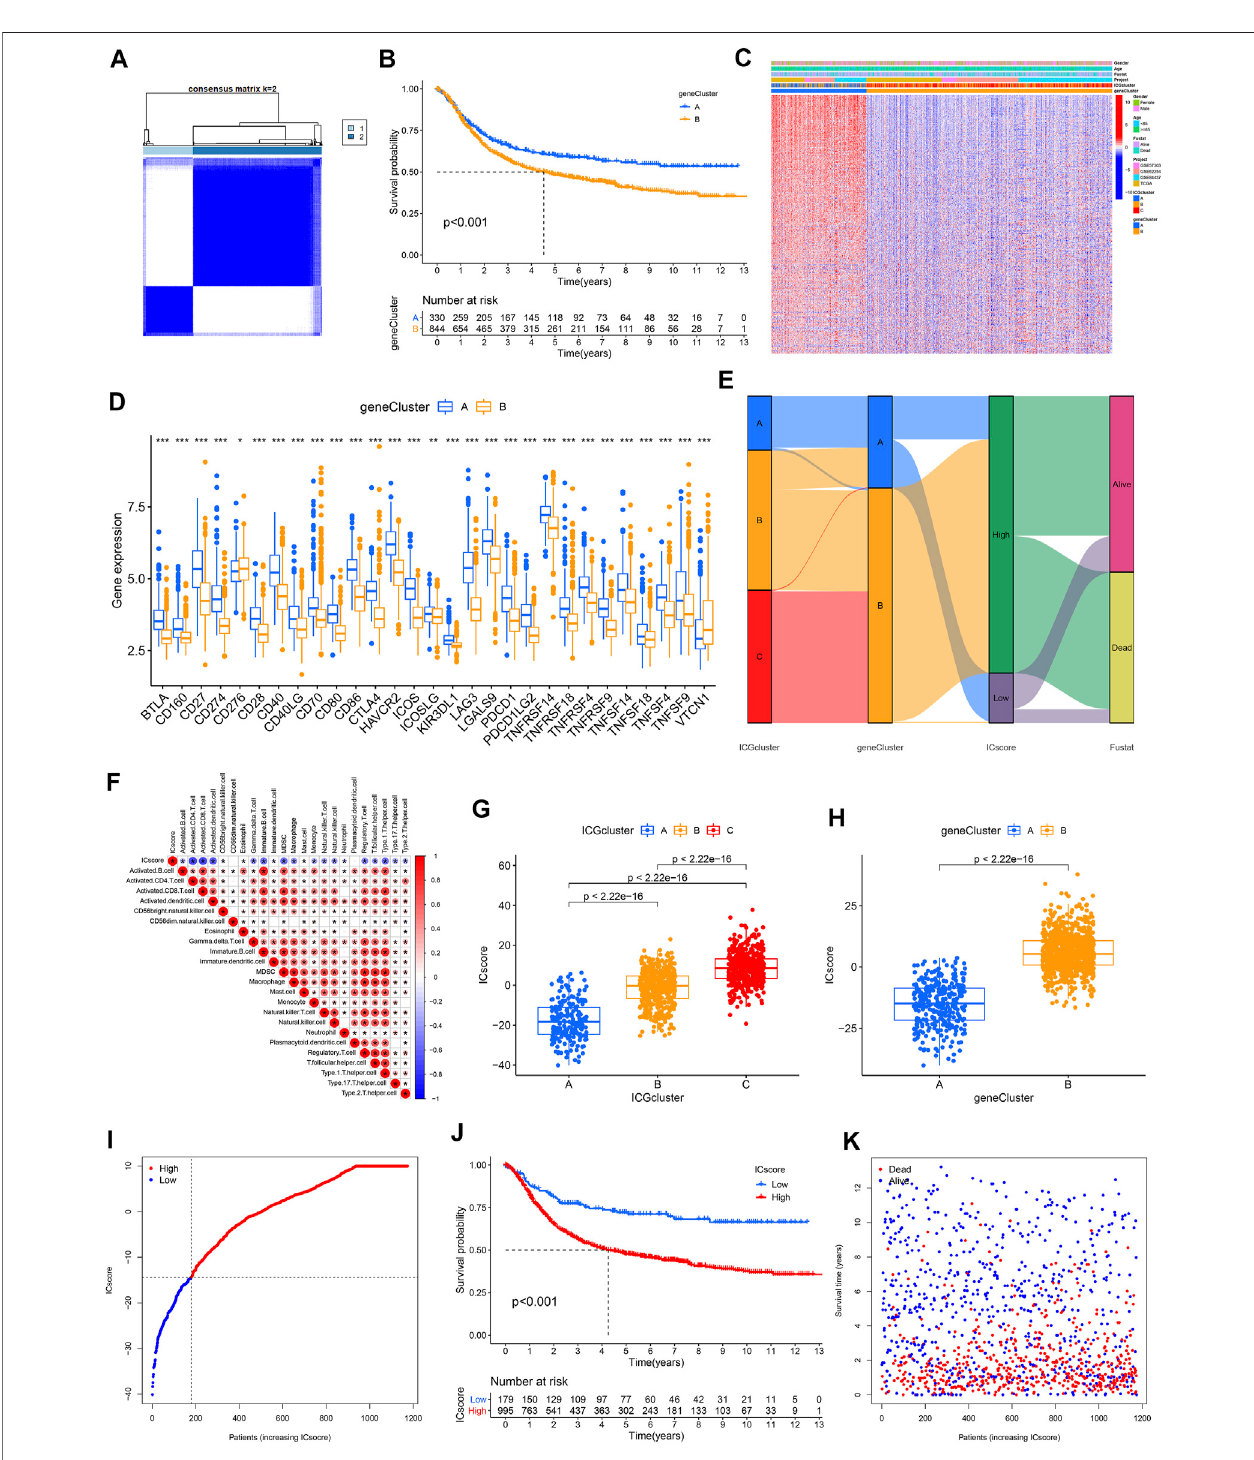
FIGURE 4 | Establishment of ICscore signatures. (A) Consistent clustering matrices based on 1,248 immune checkpoint-related genes for k = 2. (B) Survival analyses for immune checkpoint gene signatures based on 1174 GC patients. (C) Unsupervised clustering of overlapping immune checkpoint-related genes to classify patients into two genomic subtypes. (D) The expression of 31 ICGs in two clusters. (E) Alluvial diagram showing the changes of ICGcluster, geneCluster, ICscore and survival status. (F) Correlations between ICscore and the TME in fi ltrating cell. (G – H) Differences in ICscore among three ICGclusters and geneClusters. (I) GC patients were divided into two subgroups according to the optimal cutoff value of ICscore. (J) Survival analyses for low and high ICscore patient groups. (K) Survival distribution of low and high ICscore patient groups.